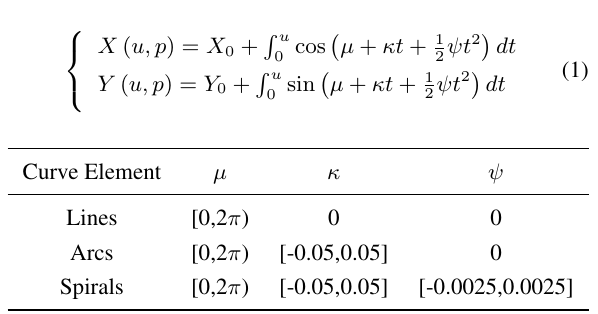
Table 1. Parameter ranges for horizontal design curve elements.